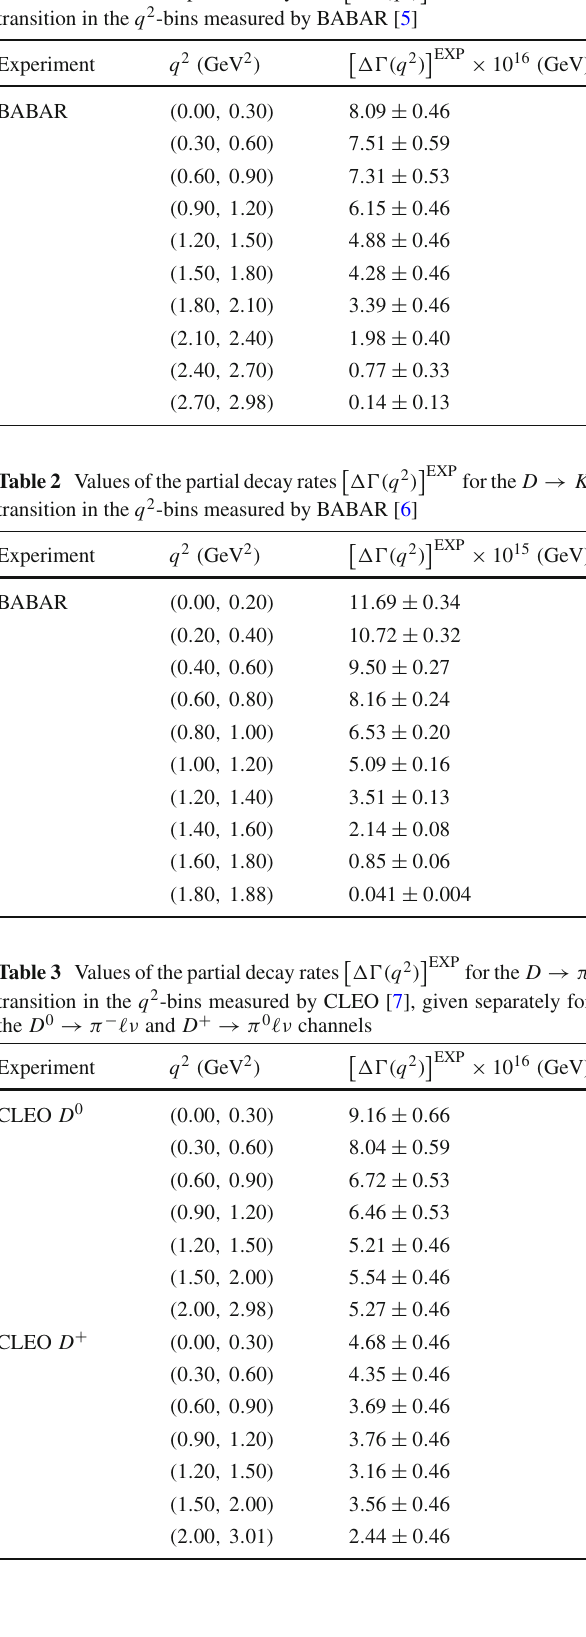
(cid:10) (cid:11) EXP for the D → K (cid:6)(cid:5)( q 2 )